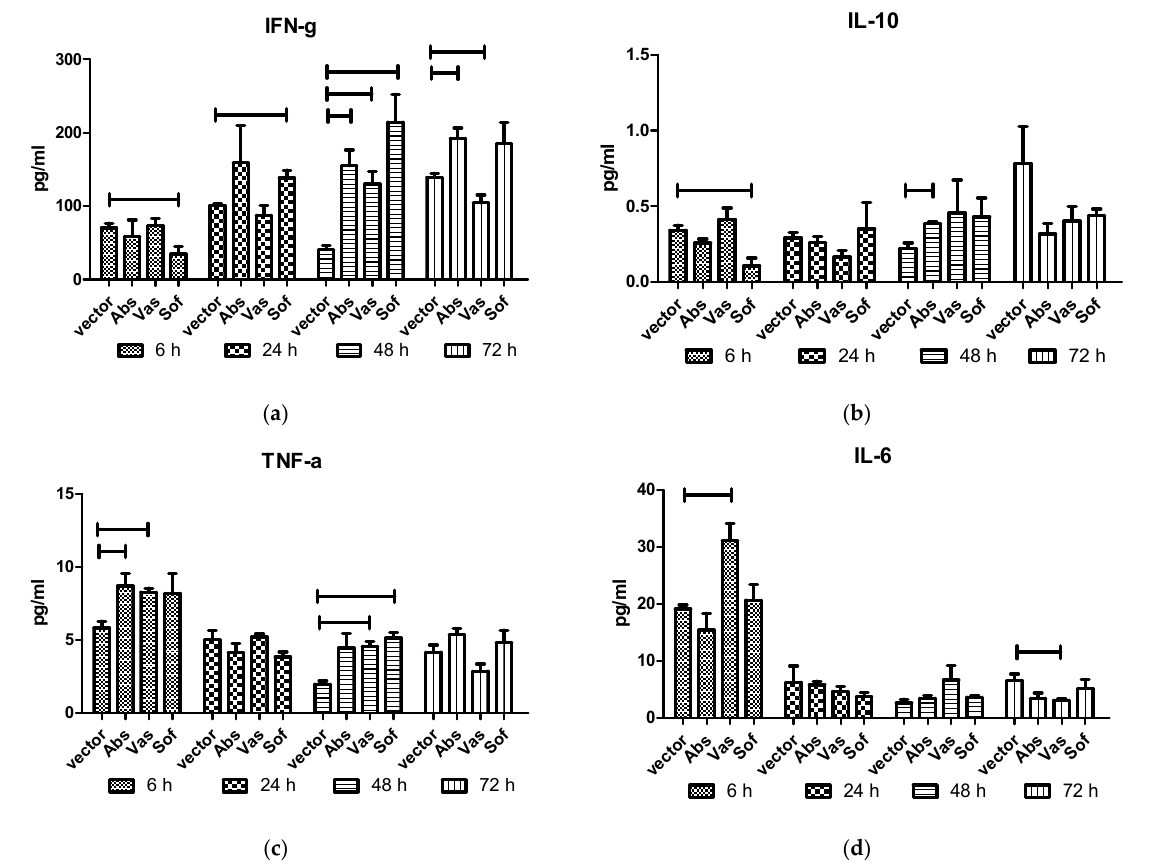
Figure 3. Cytokines in sera of mice after injection of NS1 genes of the strains of three TBEV subtypes. Plasmids encoding NS1 of Absettarov (Abs) of the European subtype, Vasilchenko (Vas) of the Siberian subtype and Sofjin-Chumakov (Sof) of the Far-Eastern subtype strains or pVax vector (vector) were intramuscularly injected into BALB/c mice, and levels of IFN- γ ( a ), IL-10 ( b ), TNF- α ( c ) and IL-6 ( d ) in sera were measured by ELISA. Each bar represents the mean value with SD of three pools of 4–5 mice sera that were run in duplicates. Statistically significant differences ( p < 0.05) derived by the Student's t-test of individual strains compared to vector are labeled. Table 1. Cytokine production in sera of NS1 gene-injected mice with statistically significant differ- ence from vector-injected mice.